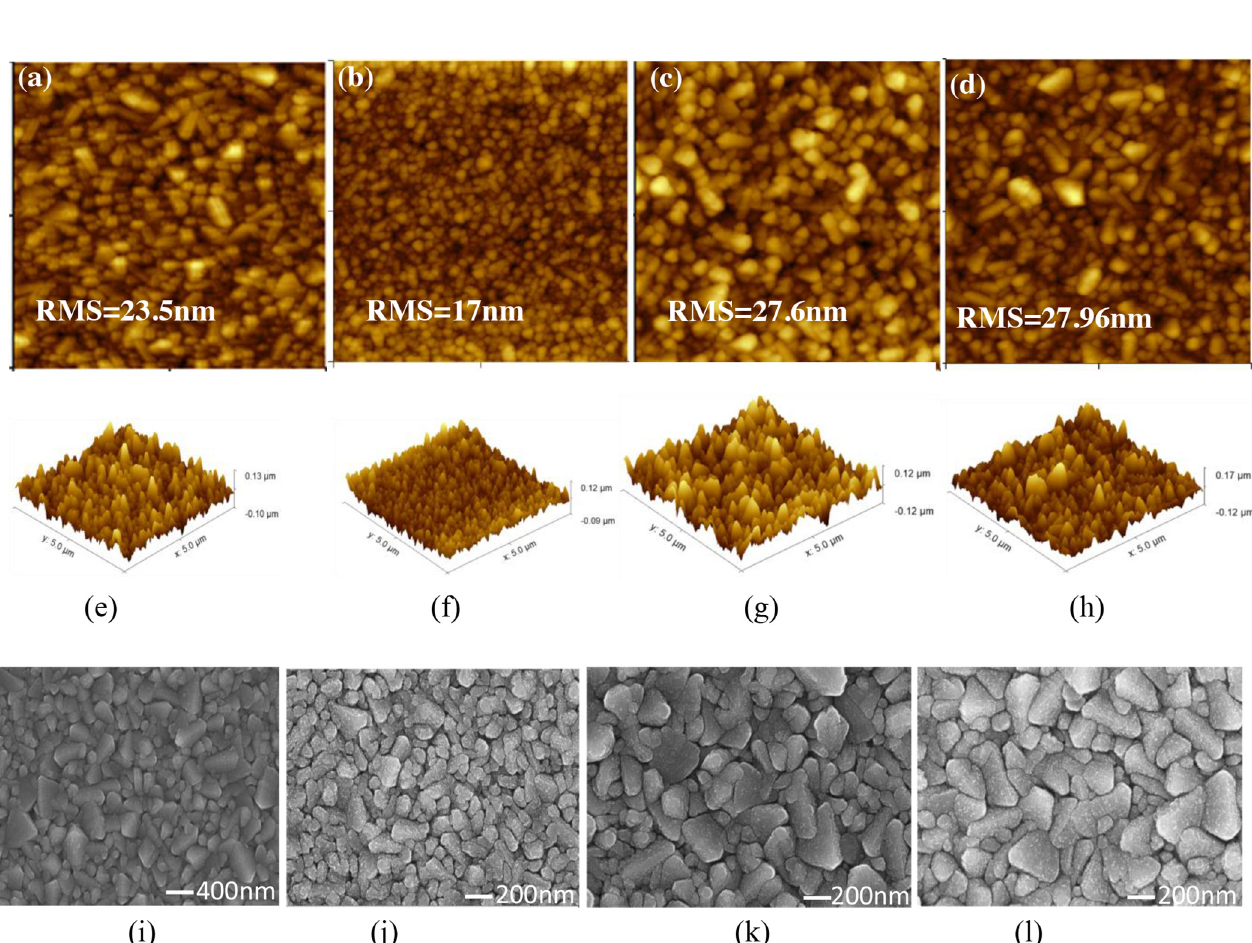
fabricated with different ratios of Ar/O 2